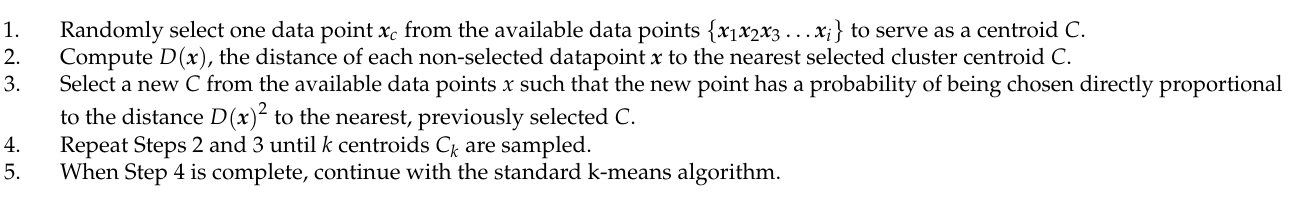
Table 1. k-means++ Pseudo-Algorithmic